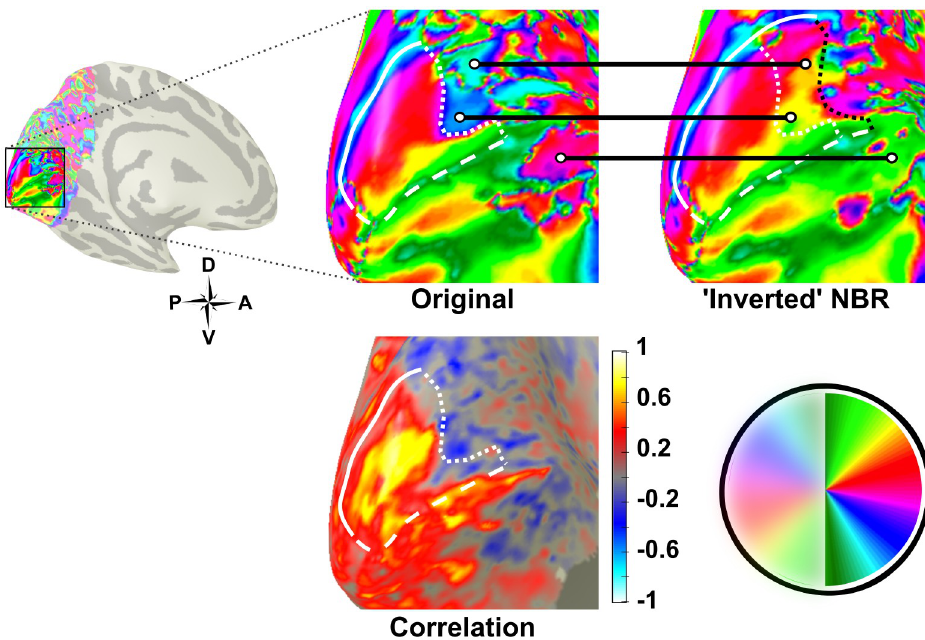
Fig 13. Retinotopic map of V1 (white) in the left hemisphere of Subject 4 before and after flipping negatively correlated time courses. The white circles indicate the same regions in the ‘original’ and ‘corrected’ data. The extension to the V1 map is indicated by the black dotted line in the ‘inverted NBR’